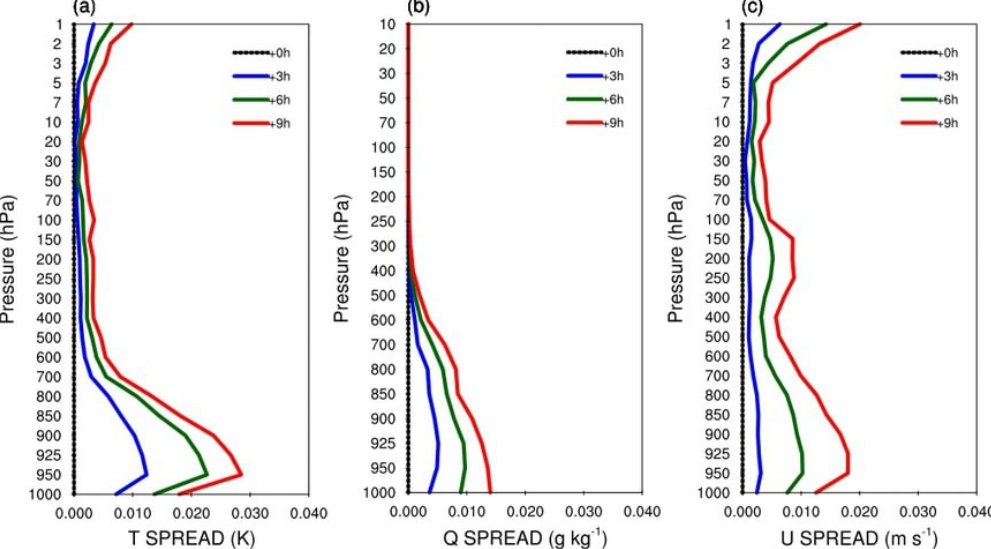
Figure 3. Differences in the ES between stochastic perturbation run (STO) and CTL (i.e., ES STO -ES CTL ) in the globally averaged vertical profiles of ( a ) temperature (in K), ( b ) specific humidity (in g kg − 1 ), and ( c ) zonal wind (in m s − 1 ) for forecast times of +3 h (blue), +6 h (green), and +9 h (red) from the initial time (+0 h; black dots) at 12:00 UTC on 22 June 2018. Variations in the ES reflect the effect of the new SPHT